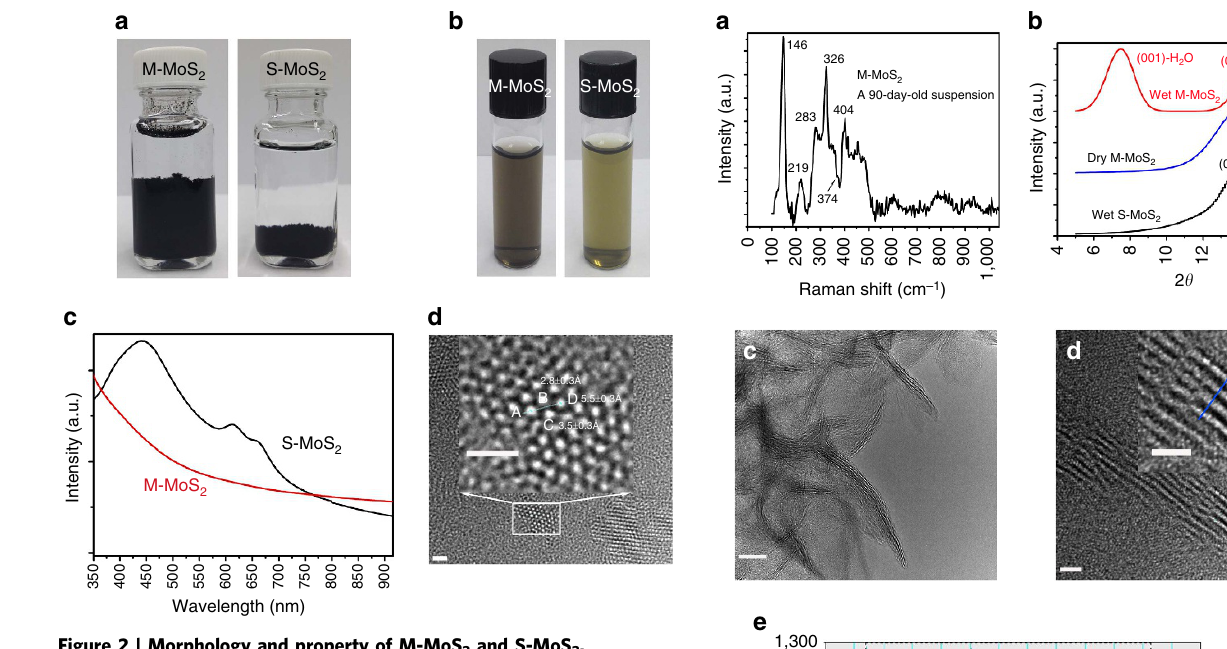
Figure 2 | Morphology and property of M-MoS 2 and S-MoS 2 . ( a ) As-prepared M-MoS 2 and S-MoS 2 in water. ( b ) Suspension of M-MoS 2 and S-MoS 2 in water. ( c ) Ultraviolet–visible absorption of M-MoS 2 and S-MoS 2 . ( d ) HRTEM image of M-MoS 2 . The region indicated by the squares is enlarged to show the atomic structure of M-MoS 2 . Scale bar, 1nm.